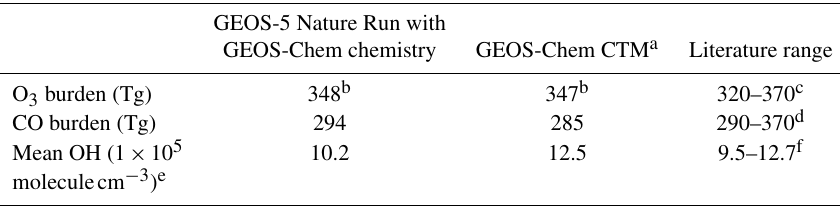
Table 1. Global tropospheric burdens.